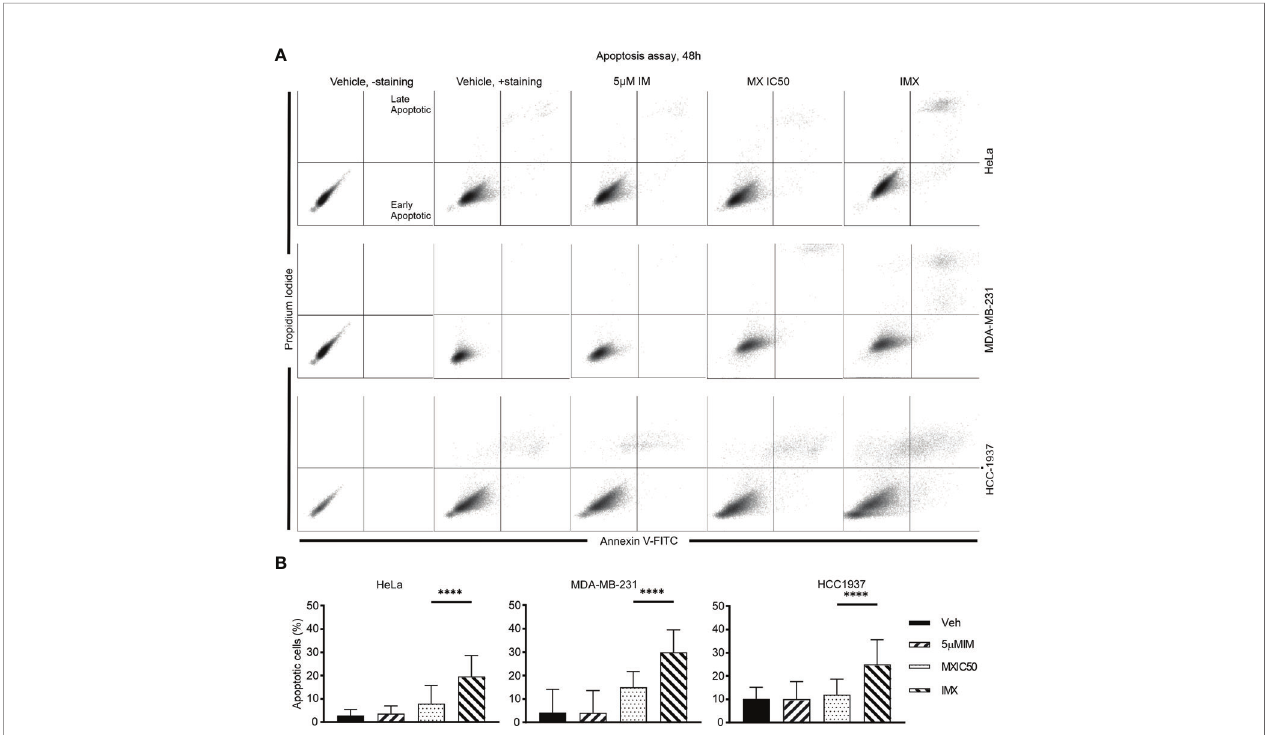
FIGURE 6 | IM induced apoptosis in HeLa, MDA-MB-231, and HCC-1937 cells after DNA damage. (A) The dot plots show distribution of early and late apoptotic populations in different cell lines. Annexin V-positive cells in the lower right quadrant are early apoptotic. Double-positive population in the upper right quadrant is late apoptotic/necrotic. The percentages of both early and late apoptotic populations are calculated as total percent of apoptotic population. (B) The bar chart shows the percent of apoptotic cells in total population under different treatments in different cell lines.